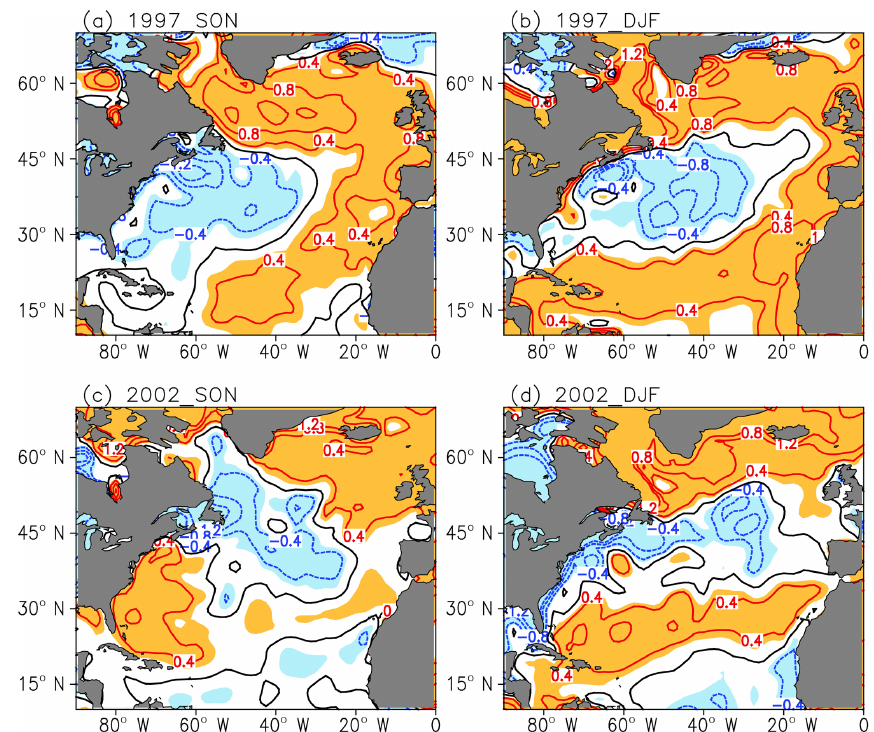
Figure 8. The horizontal distribution of skin temperature anomalies ( ◦ C) based on assimilated meteorological data during the (a) autumn and (b) winter of 1997. Panels (c, d) are as (a, b) but during 2002.